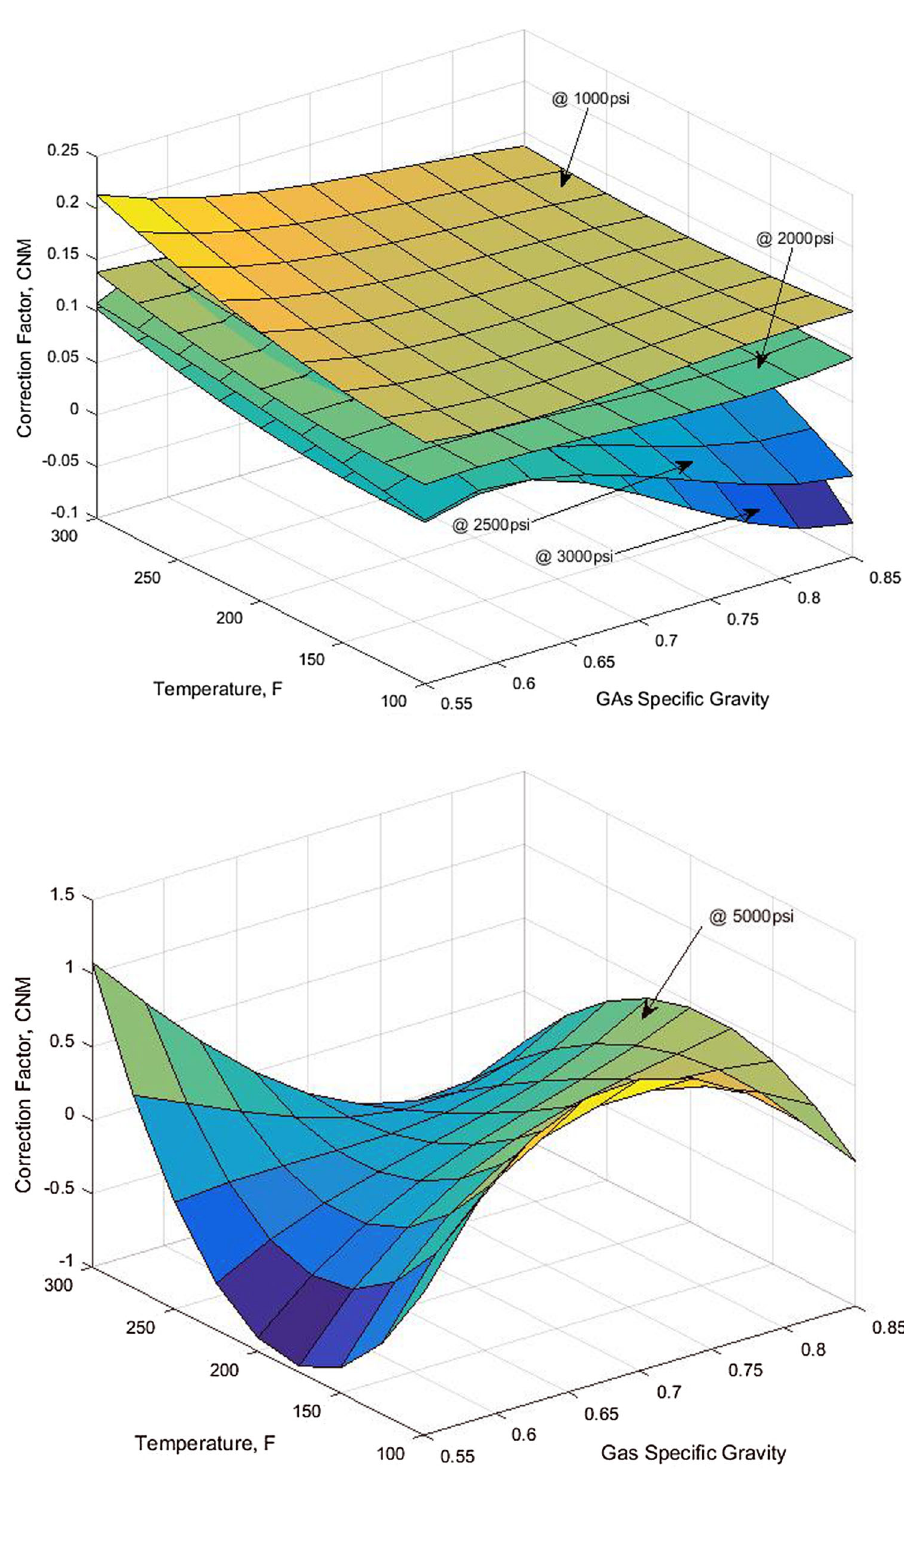
Fig. 13 Isobar plots for natural gases in Table 1 at 1000, 2000, 2500 and 3000 psi